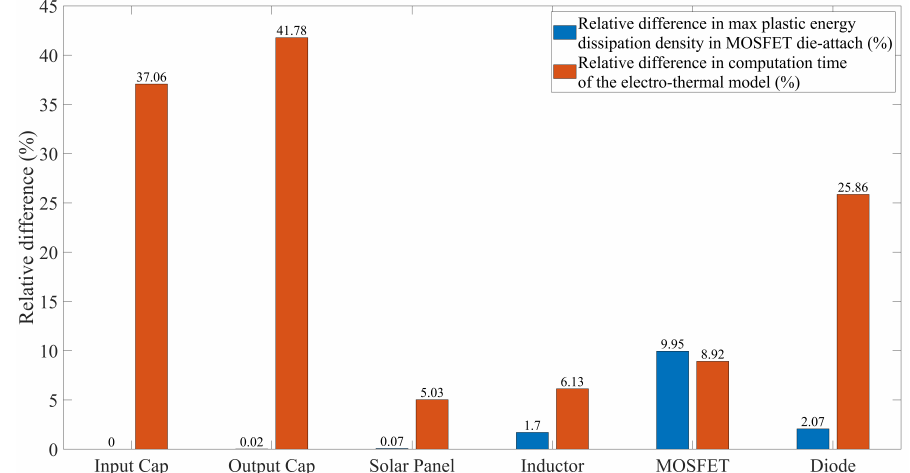
Figure 13. The relative difference in maximum plastic energy dissipation density in the MOSFET die-attach (%) and computation time of the electro-thermal model (%) when excluding a certain temperature dependent electrical variable from the electro-thermal DC–DC converter